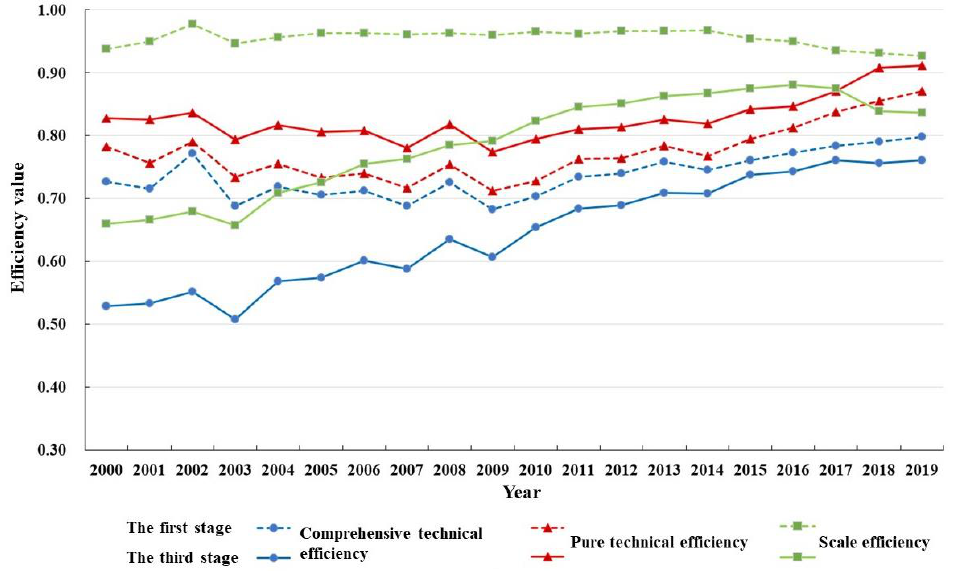
Figure 4. Evolving trend of grain production resource allocation efficiency in the major grain-producing areas in China from 2000 to 2019. Table 4. Grain production resource allocation efficiency in the major grain-producing areas in China from 2000 to